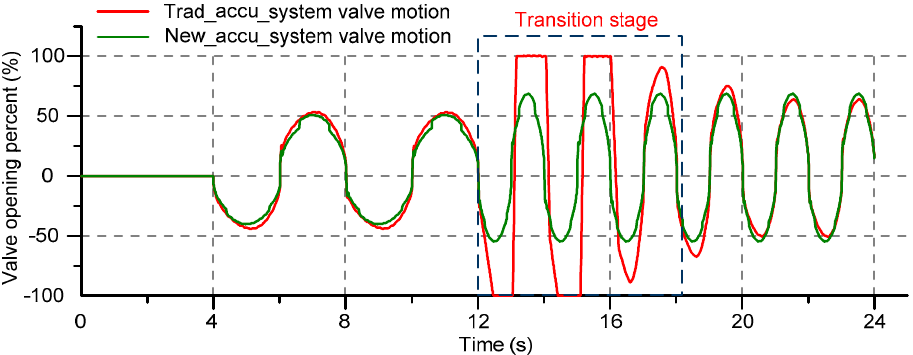
Figure 10. Comparison of the valve motions of the two systems when the sine signal frequency suddenly increases from 0.25 Hz to 0.5 Hz.